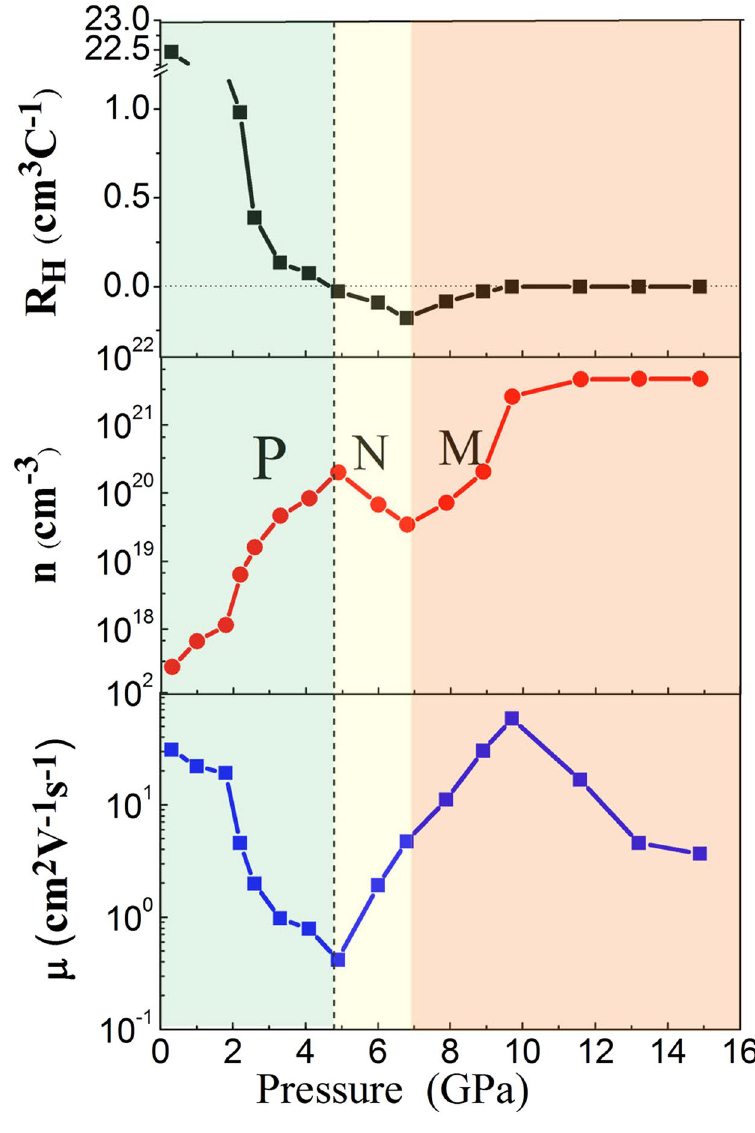
Figure 3. Pressure dependence of Hall coefficient, carrier concentration, and mobility of GaSb at room temperature. P, N, M represent P-type semiconductor, N-type semiconductor and Metallization, respectively. The vertical dashed line indicates the carrier-type